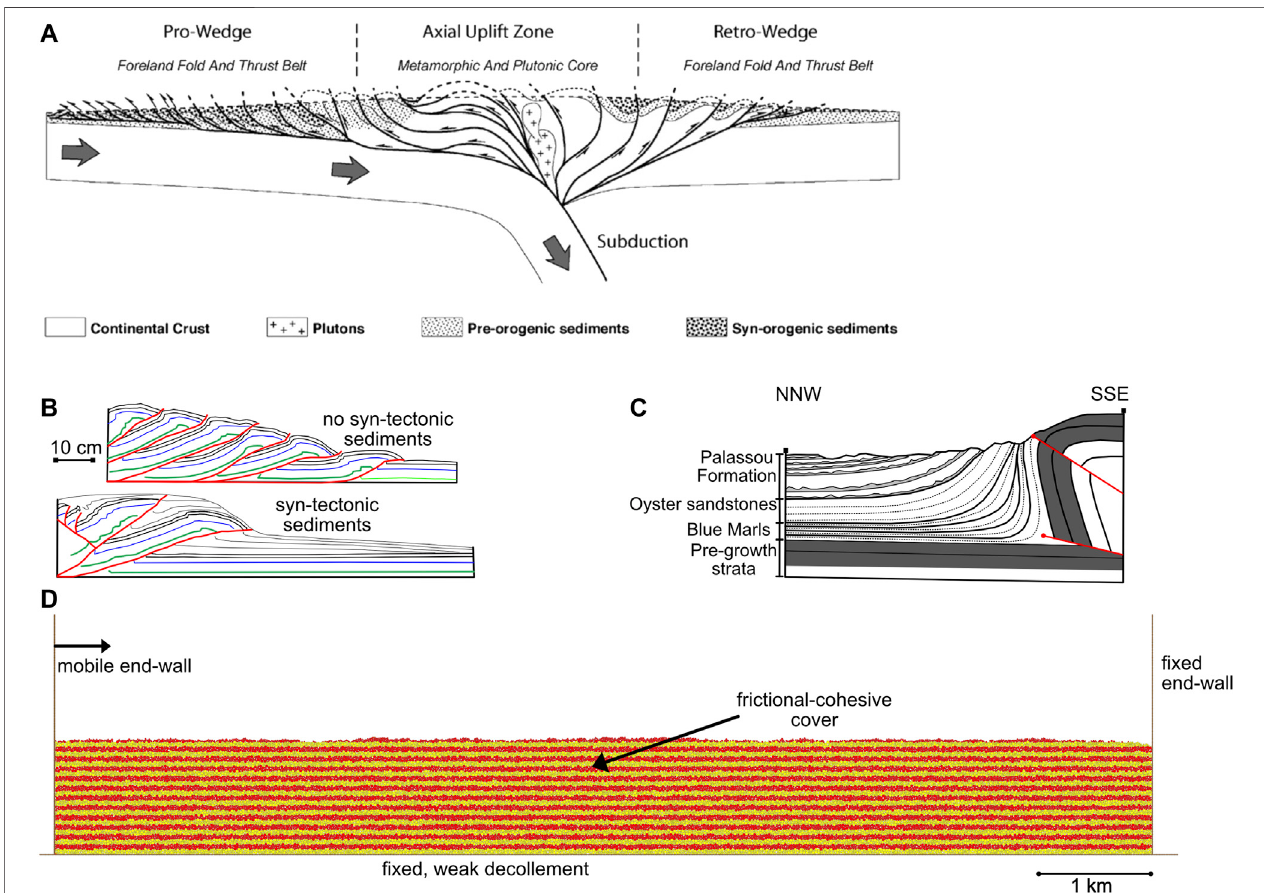
FIGURE 1 | (A) Conceptual model of a doubly-vergent thrust wedge system produced by continent – continent collision redrawn from Hardy et al . , (2009), (B) Analogue models of thrust wedges redrawn from Storti and McClay (1995) – the upper model shows thrust imbrication without syn-tectonic sedimentation: note closely spaced multiple imbricates and use of basal decollement. The lower panel illustrates thrusting with syn-tectonic sedimentation: note limited number of thrusts which “ root ” near the back wall and the overriding of syn-tectonic sediments. (C) Cross-section through the north-western Mouthoumet Front (NE Pyrenees) showing growth structures involving the Eocene Blue Marls, Oyster Sandstones and Palassou Formation (redrawn from Christophoul et al., 2003), (D) Boundary conditions and 2D model set-up used in the experiments presented herein.